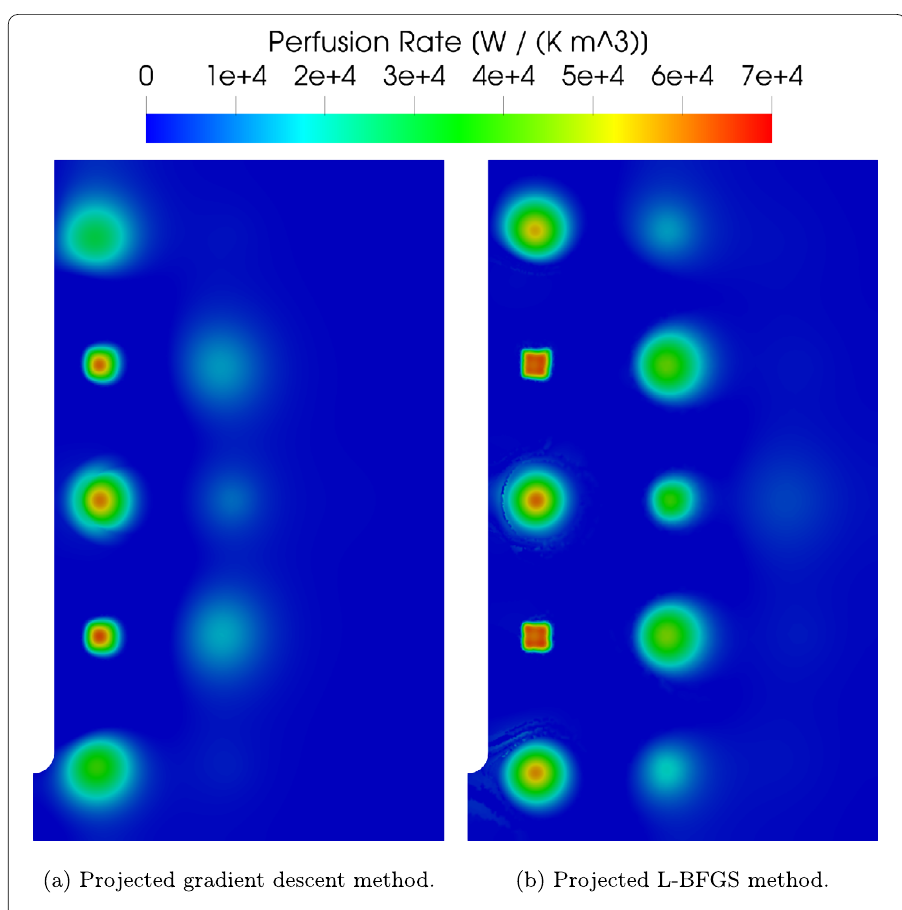
Figure 6 Identified perfusion rates for multiple measurements